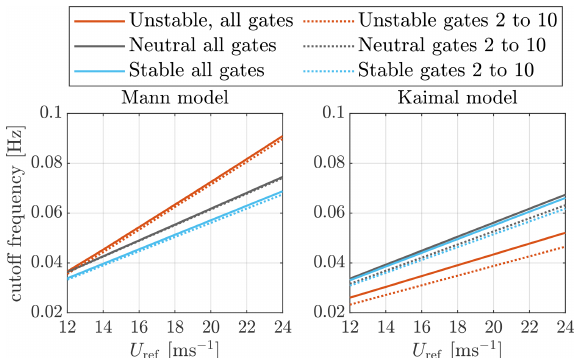
Figure 5. The dependency of cutoff frequencies in hertz on the mean wind speed. The cutoff frequency corresponds to − 3dB at the G RL magnitude. In “all gates” the lidar measurement gates from 1 to 10 are considered. In “gates 2 to 10” the lidar measurement gates from 2 to 10 are considered.